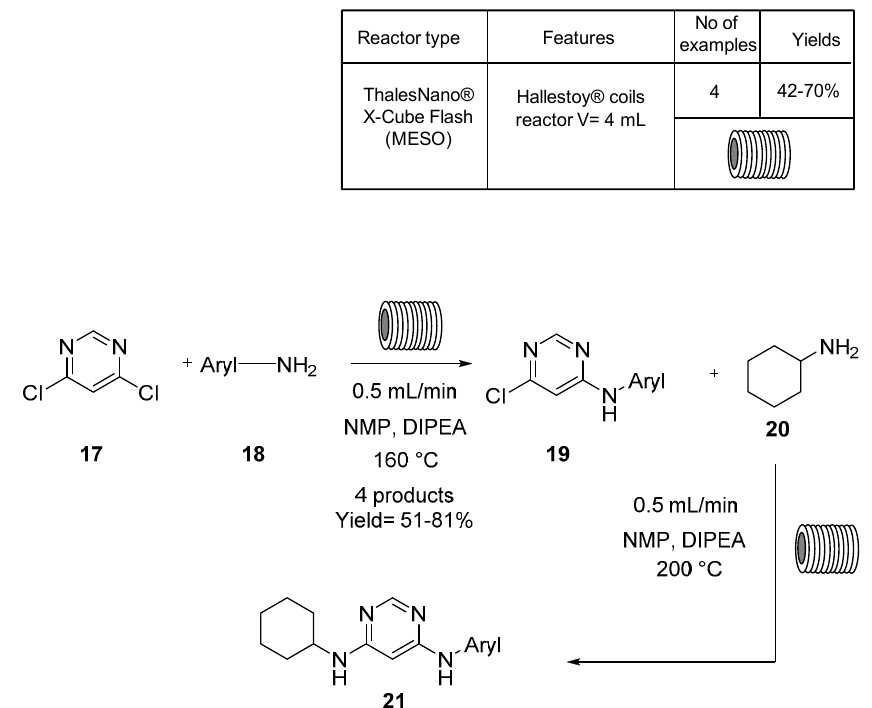
Scheme 6. Two-step one flow synthesis of cardiomygenesis-inducing